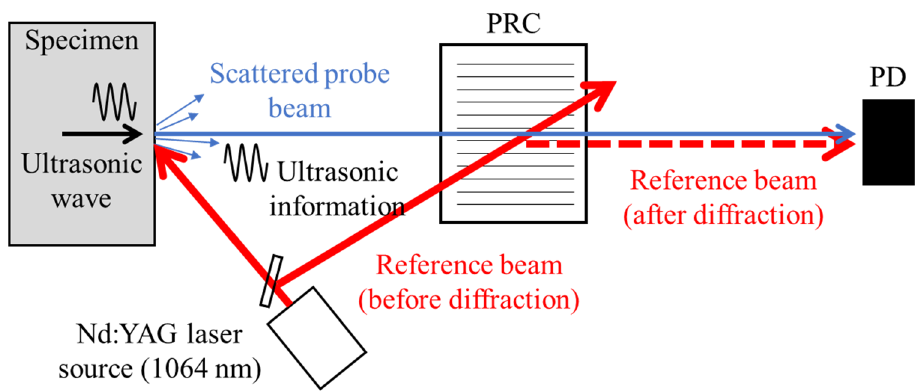
Figure 1. Schematic configuration of photorefractive interferometric system.